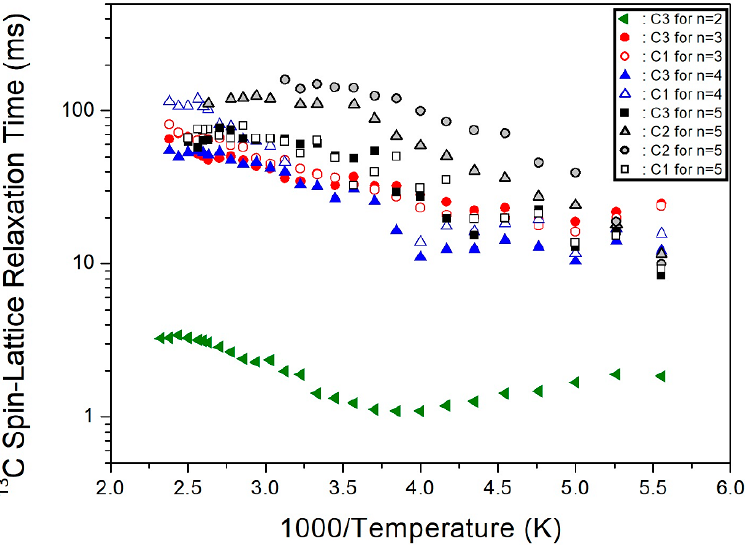
Figure 7. Temperature dependence of 13 C NMR spin-lattice relaxation times (T 1 ρ ) in [NH 3 (CH 2 ) n NH 3 ]CuCl 4 ( n = 2, 3, 4, and 5).